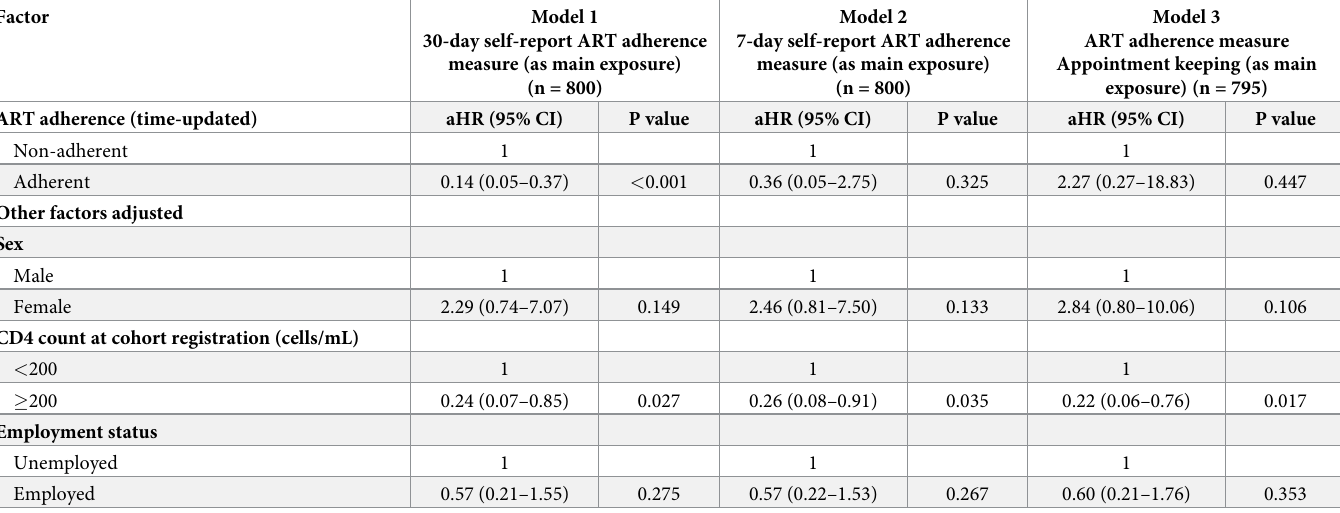
Table 3. Associations of ART adherence and virologic failure, adjusting for baseline and time-dependent patient